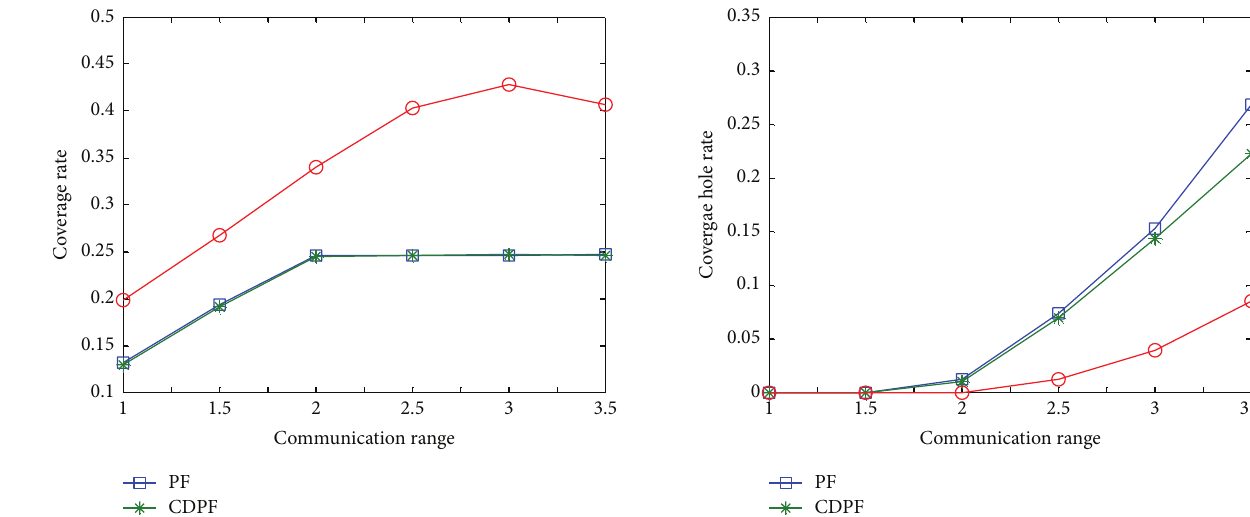
each scheme in 3000 time stamps for one simulation and run it ten times for each parameter set to obtain average value.